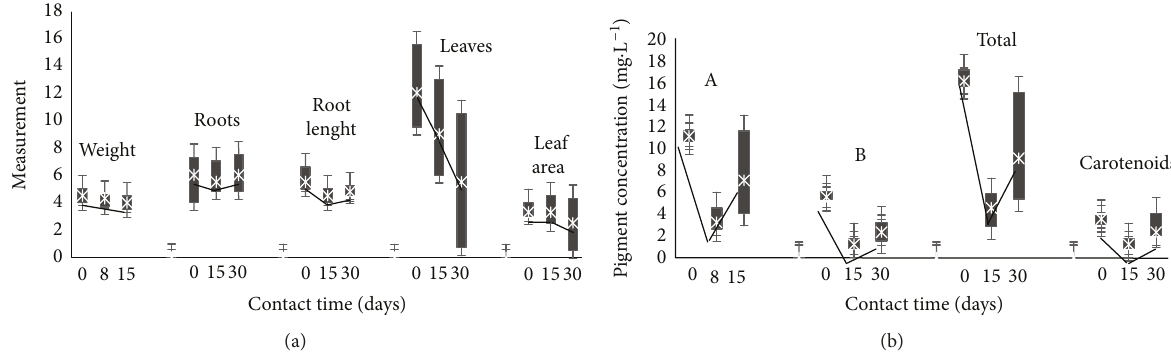
Figure 9: Willow tolerance (a) biomass parameters: weight (g), root number, root length (cm), leaf number, and leaf area (cm 2 ); (b) pigment concentration (mg · L − 1 ) at di ff erent contact times.